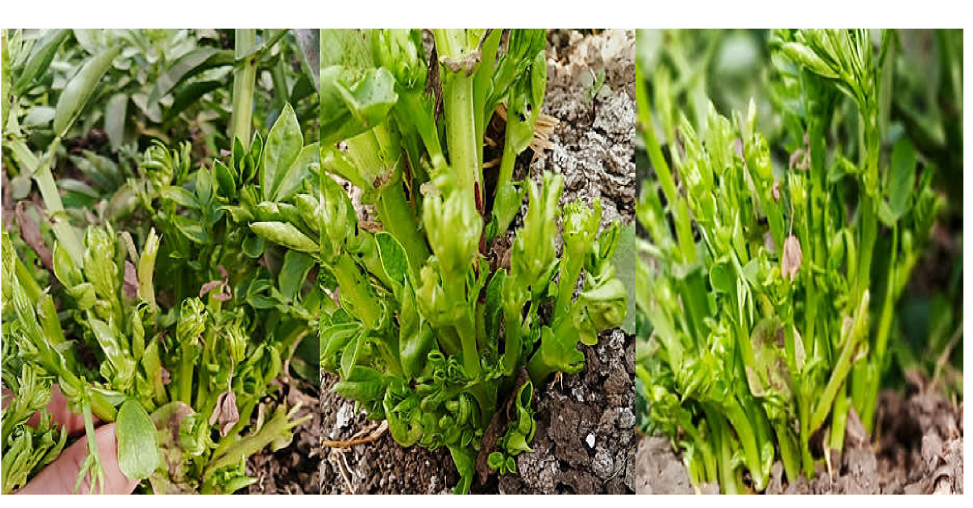
Figure 1. View of experimental field showing natural infection of faba bean associated with